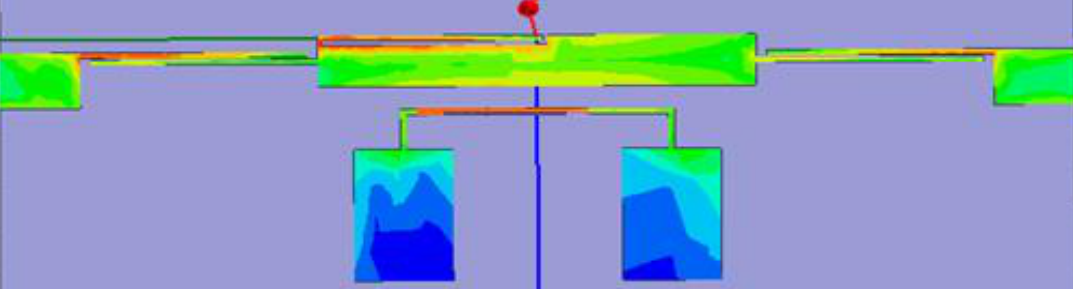
Figure 19. Current distribution of the UWB filter with a notch at 7.5 GHz.